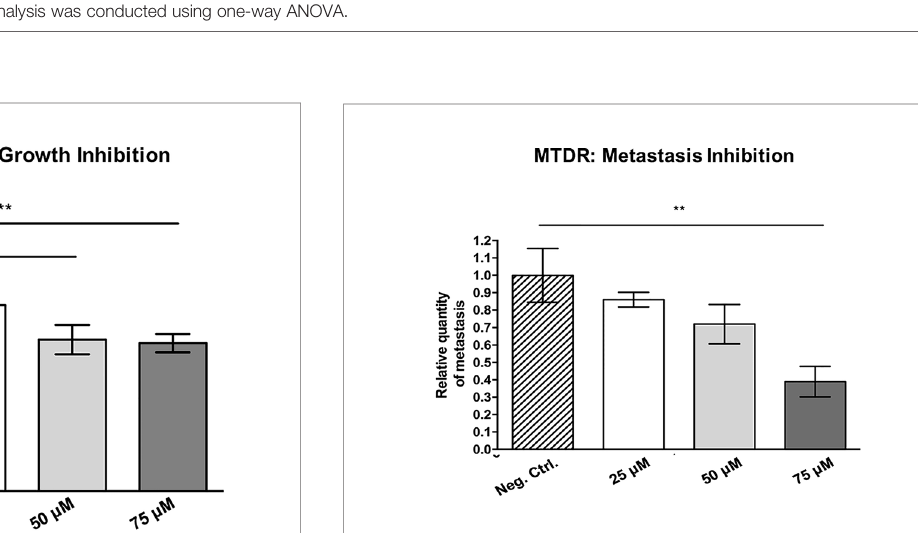
FIGURE 13 | MTDR preferentially targets and prevent cancer cell metastasis. MDA-MB-231 cells and the well-established chorio-allantoic membrane (CAM) assay in chicken eggs were used to quantitatively measure spontaneous tumor cell metastasis. See Materials & Methods for speci fi c details. After 8 days of drug administration, the Lower CAM was collected to evaluate the number of metastatic cells, as analyzed by qPCR with speci fi c primers for Human Alu sequences. Note that MTDR showed signi fi cant effects on MDA-MB-231 metastasis, with an inhibition of >60%, at a concentration of 75 m M (n ≥ 7). Averages are shown ± SEM. **p < 0.01. Statistical analysis was conducted using